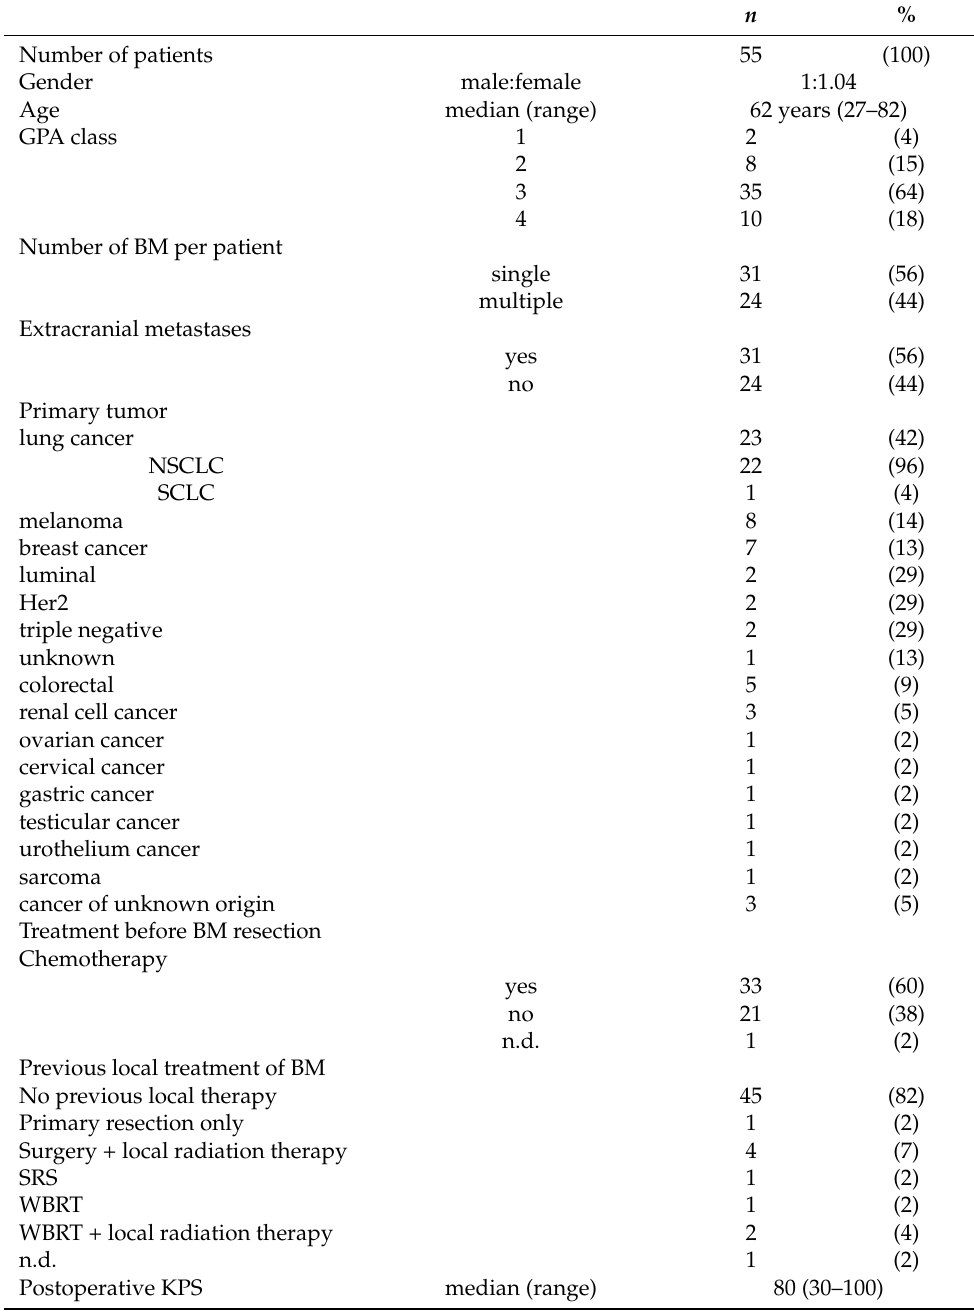
Table 1. Patients